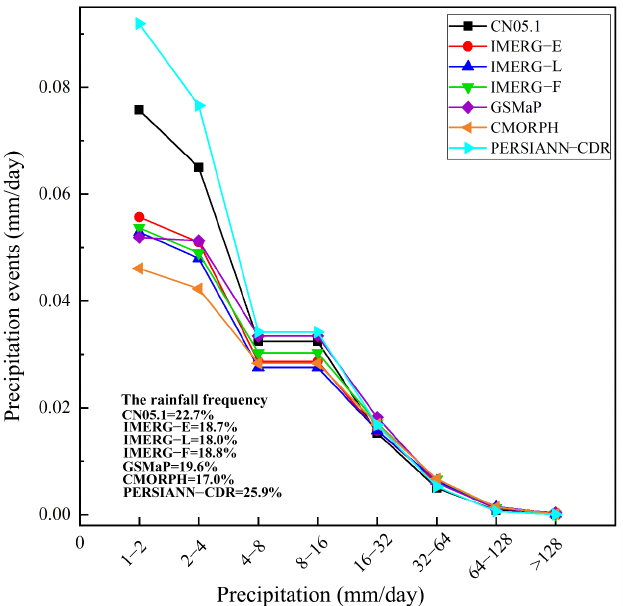
Figure 3. The frequency of daily precipitation from ground interpolation product (CN05.1) and six satellite products. 3.2. Monthly and Seasonal Precipitation The scatter density plots of monthly precipitation between each satellite product and ground interpolation product of CN05.1 are shown in Figure 4. It can be seen that more grids in China presented a precipitation intensity lower than 2000 mm/month, and, thus, the high – density points were not easily found in Figure 4. In summary, the CC and KGE of monthly scale satellite precipitation were higher than those at the daily scale. Specifi- cally, the range of monthly RMSEs was from 23.79 to 69 mm/month. The range of daily